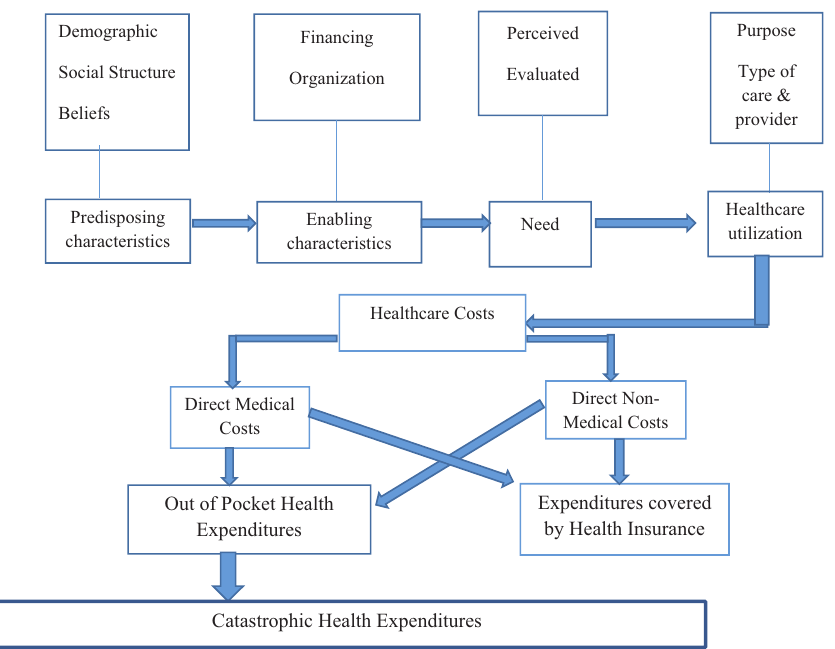
Figure 1. Determinants of household ’ s OOP health expenditures using Andersen ’ s behavioral model of healthcare